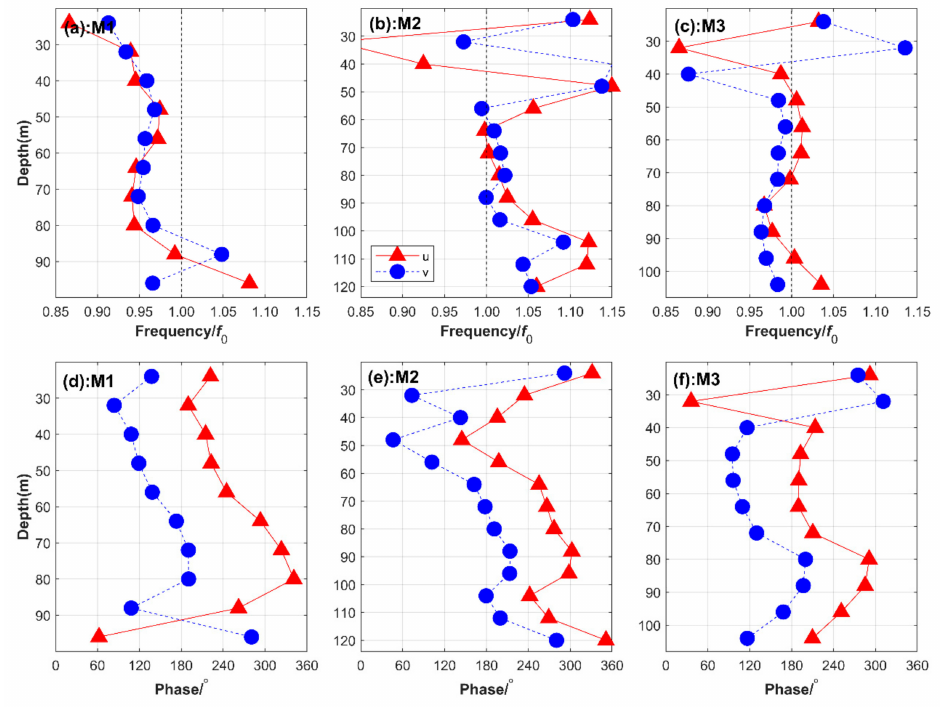
Figure 9. The peak frequency and phase of NIWs for M1 ( a , d ), M2 ( b , e ) and M3 ( c , f